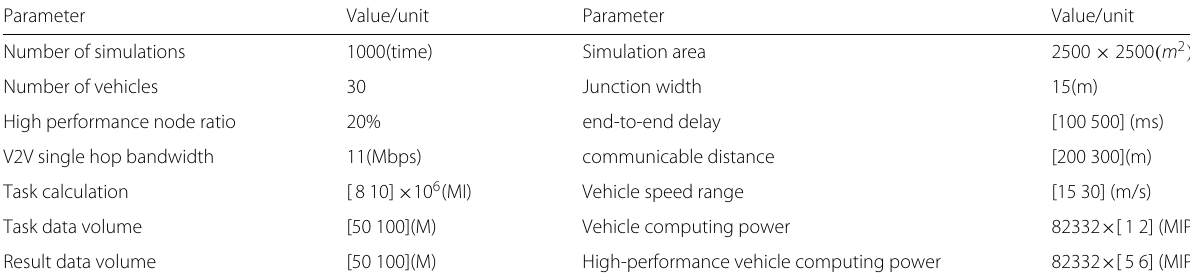
Table 1 Simulation parameter table